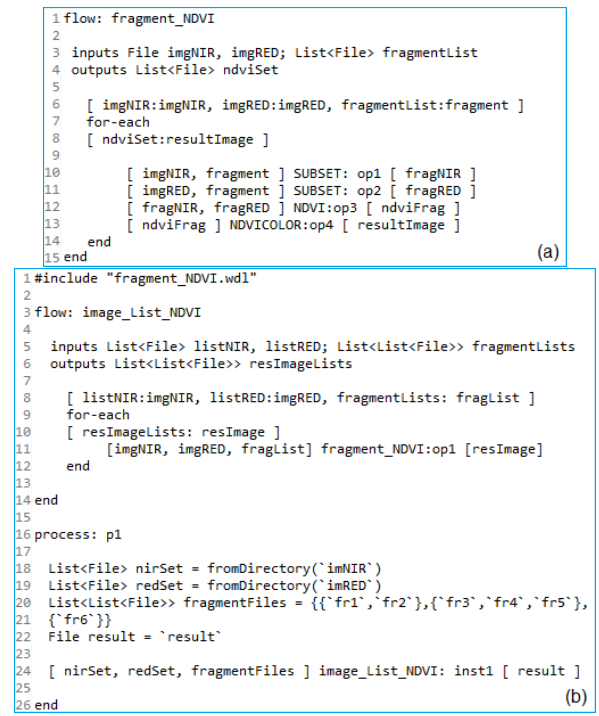
Figure 8. Double for-each